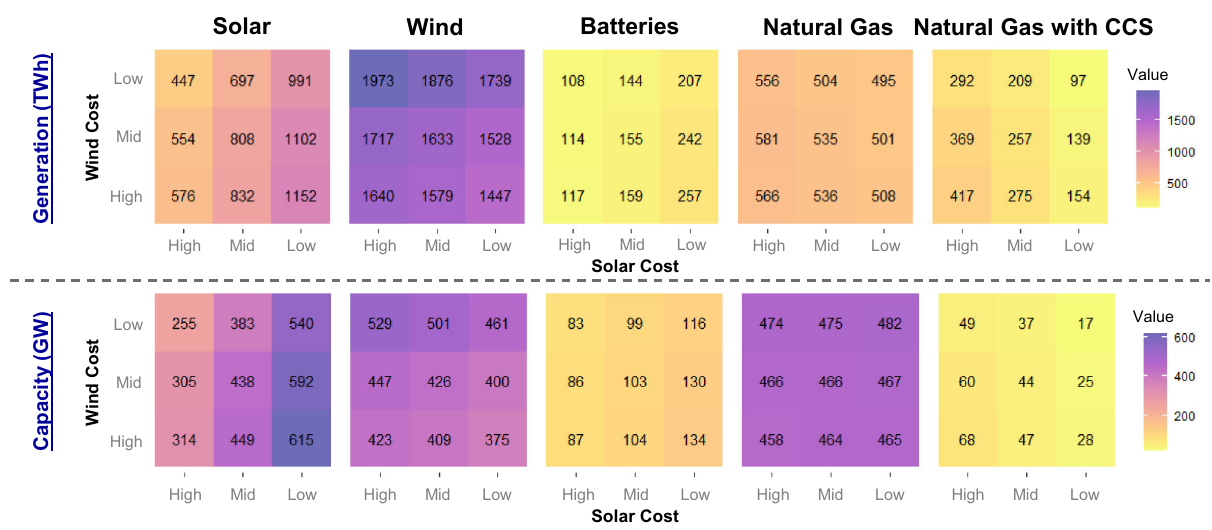
shownby color, and regions are shownby shape (regionalde fi nitions are shown in Fig. 3). Note that points are jittered horizontally within a column for greater visi- bility of individual